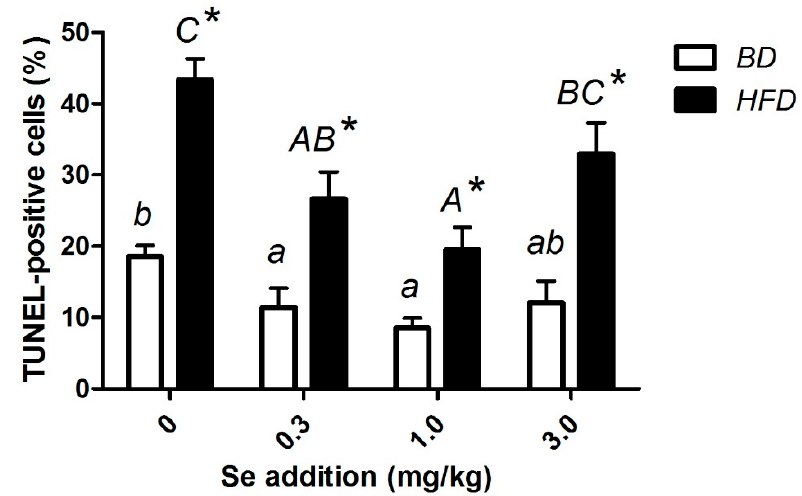
Figure 4. Levels of cell apoptosis of the liver determined by the TUNEL assay. * Different from the BD at that Se addition, p < 0.05. a–b Within BD groups, means without a common letter differ, p < 0.05. A–C Within HFD groups, means without a common letter differ, p < 0.05.